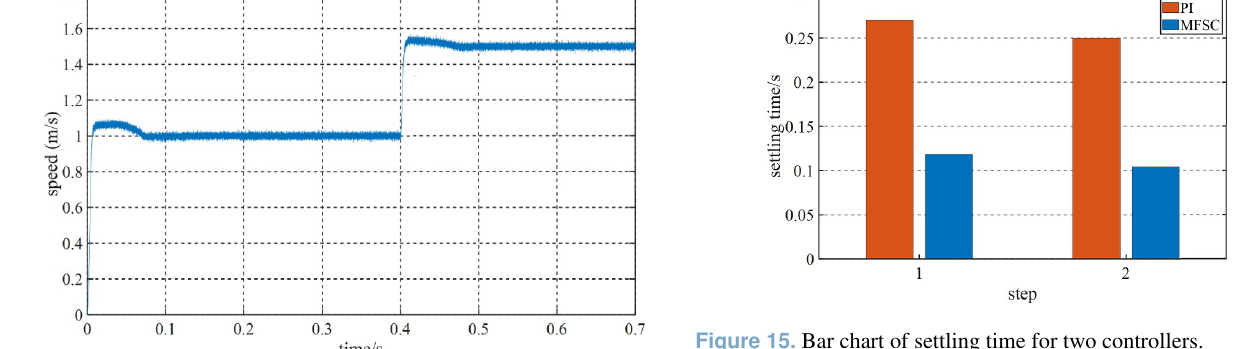
Figure 15. Bar chart of settling time for two controllers.